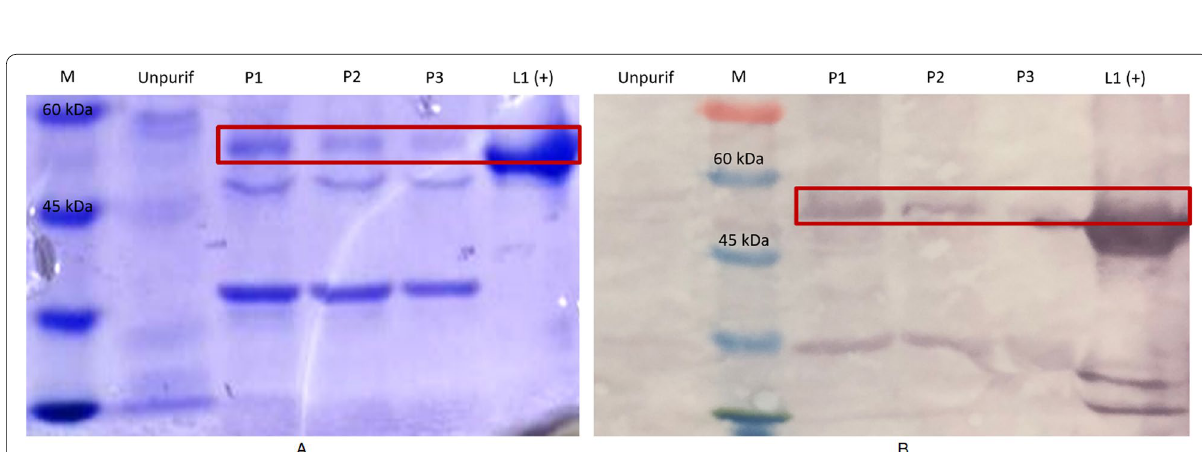
Fig. 8 Proteolytic removal analysis of poly histidine-tagged SUMO fusion protein from L1-HPV52, compared to commercial L1-HPV52 A SDS-PAGE, B western blot with anti-L152-AP. Lane P1-P3 represent are fractions of our cleaved products; P4 is commercial L152 (Creative Diagnostic-DAGF-234) as a positive control, and lane M is molecular weight size marker (kDa)